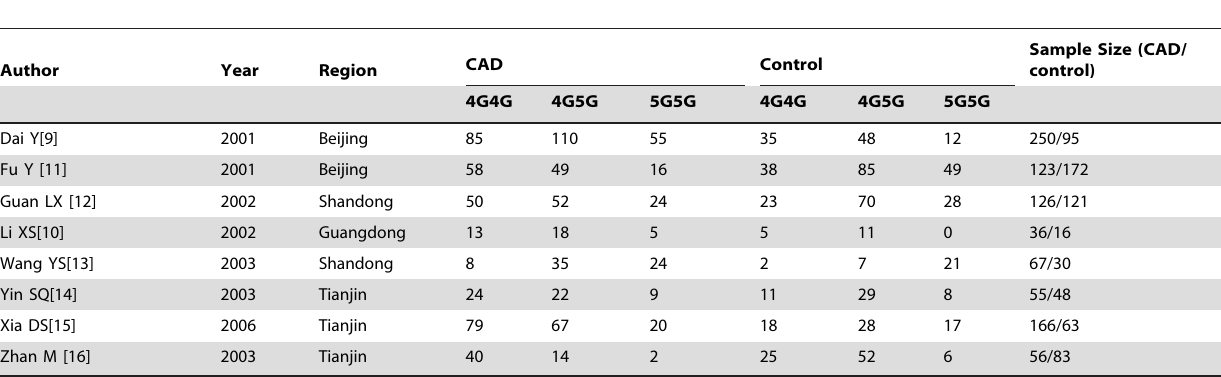
Table 1. Characteristics of the investigated studies of the association between PAI-1 4G/5G gene polymorphism and coronary artery disease.